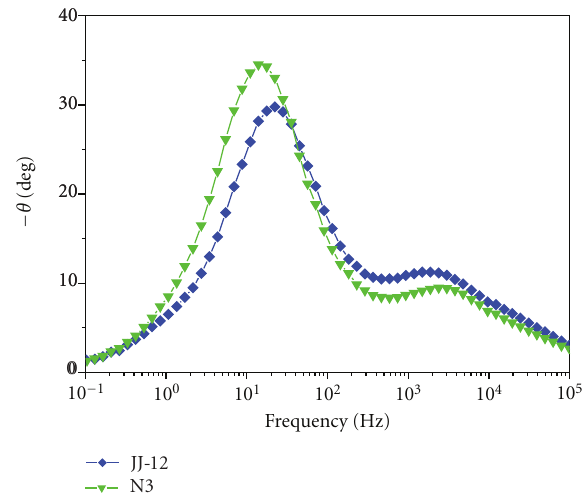
Figure 6: Electrochemical impedance spectra of JJ-12 and N3- sensitized cells in the form of a bode phase plot(Measured under open-circuit conditions and AM 1.5 simulated sunlight illumination (100 mWcm − 2